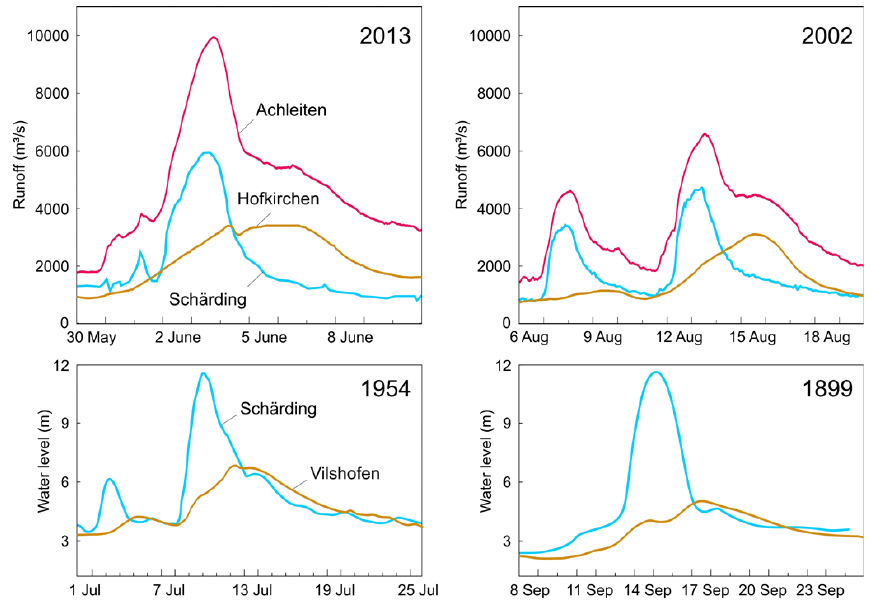
Fig. 9. (top) Runoff hydrographs for the June 2013 and August 2002 events at the confluence of the Inn (Schärding) and the Bavarian Danube (Hofkirchen). Runoff at Achleiten is the sum of Schärding and Hofkirchen plus the Ilz, a minor tributary. (bottom) Water level hydrographs for the July 1954 and September 1899 events at similar locations (Vilshofen is close to Hofkirchen). The 1954 peak discharges at Schärding and Vilshofen were 6300 and 3320m 3 s − 1 , respectively, and the 1899 peak discharges were 6400 and 2370m 3 s − 1 , respectively.